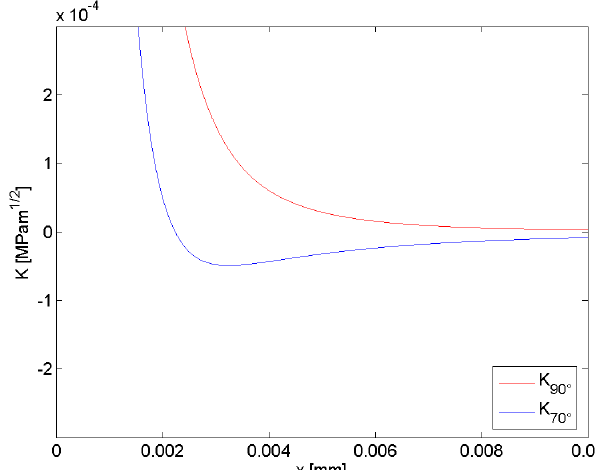
Figure 6: Magnified stress intensity factors induced for 70° and 90° inclined dislocations as a function of the distance to the crack tip in the wake. For x larger than 2r pl , the stress intensity of the 70° inclined dislocation becomes somewhat shielding compares to the 90° inclined dislocation which remains anti-